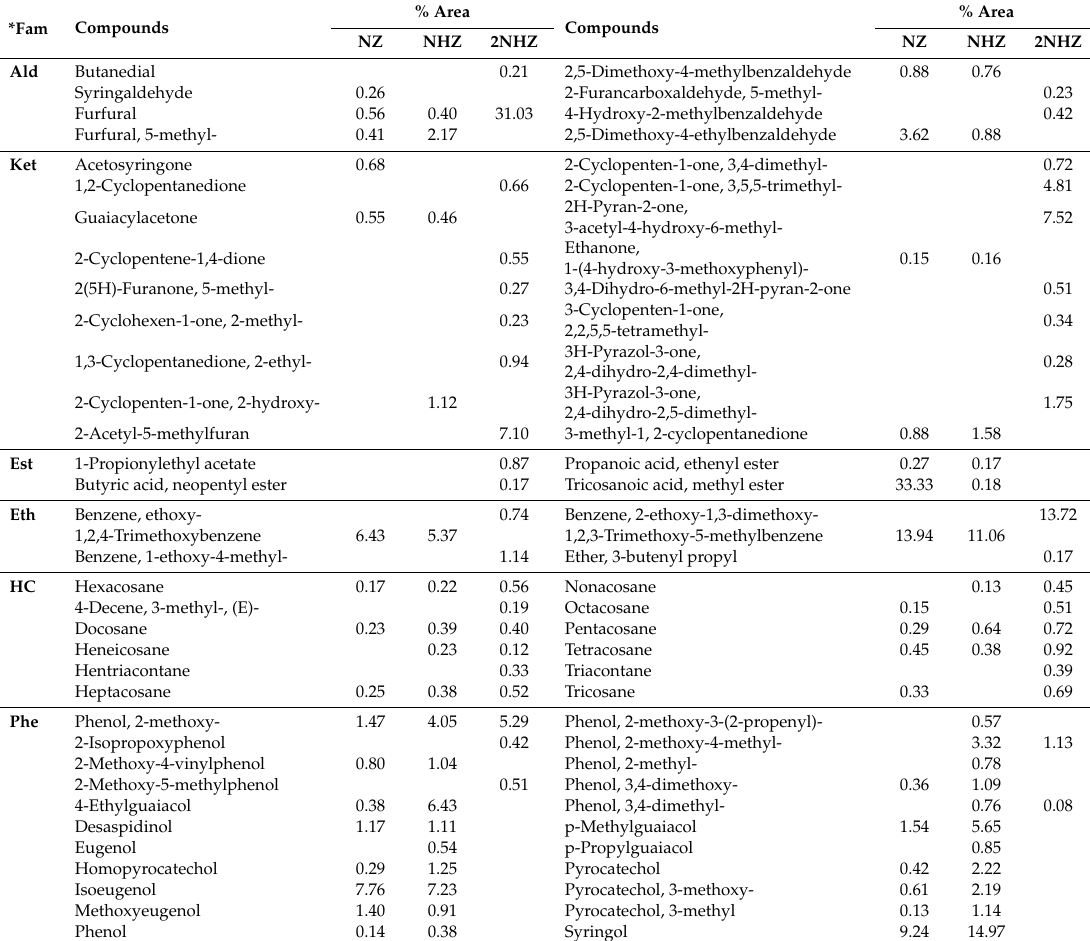
Table 4. Main components of bio-oil obtained from catalytic Oak pyrolysis at 723